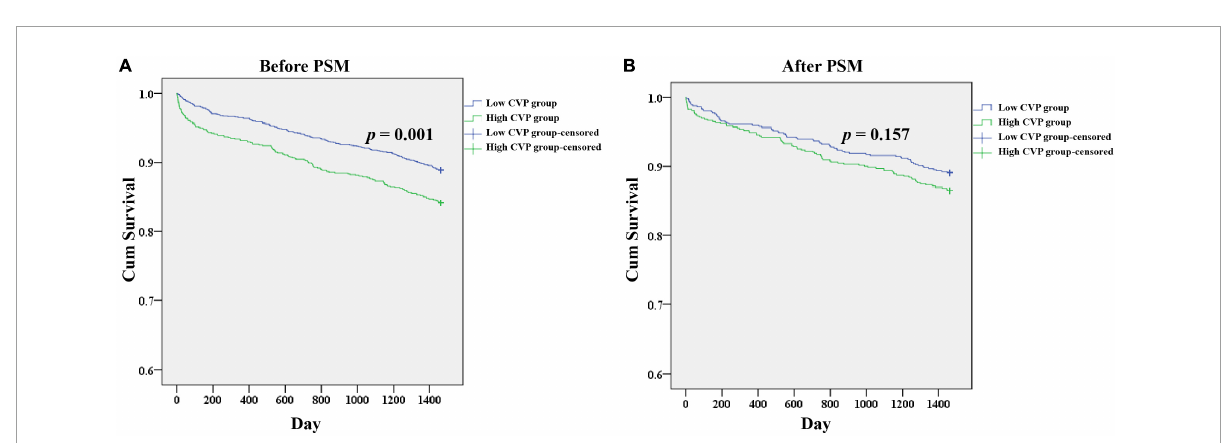
FIGURE4 Kaplan-Meier survival analysis plots for 4-year overall survival in patients undergoing CABG. The analysis was limited to patients in the CareVue system. A significantly lower 4-year survival rate can be observed in the High CVP group in patients before PSM (A) , but not in patients after PSM (B) . p value was calculated by log-rank test and indicated in the plots. CABG, Coronary artery bypass grafting; CVP, Central venous pressure; PSM, propensity score